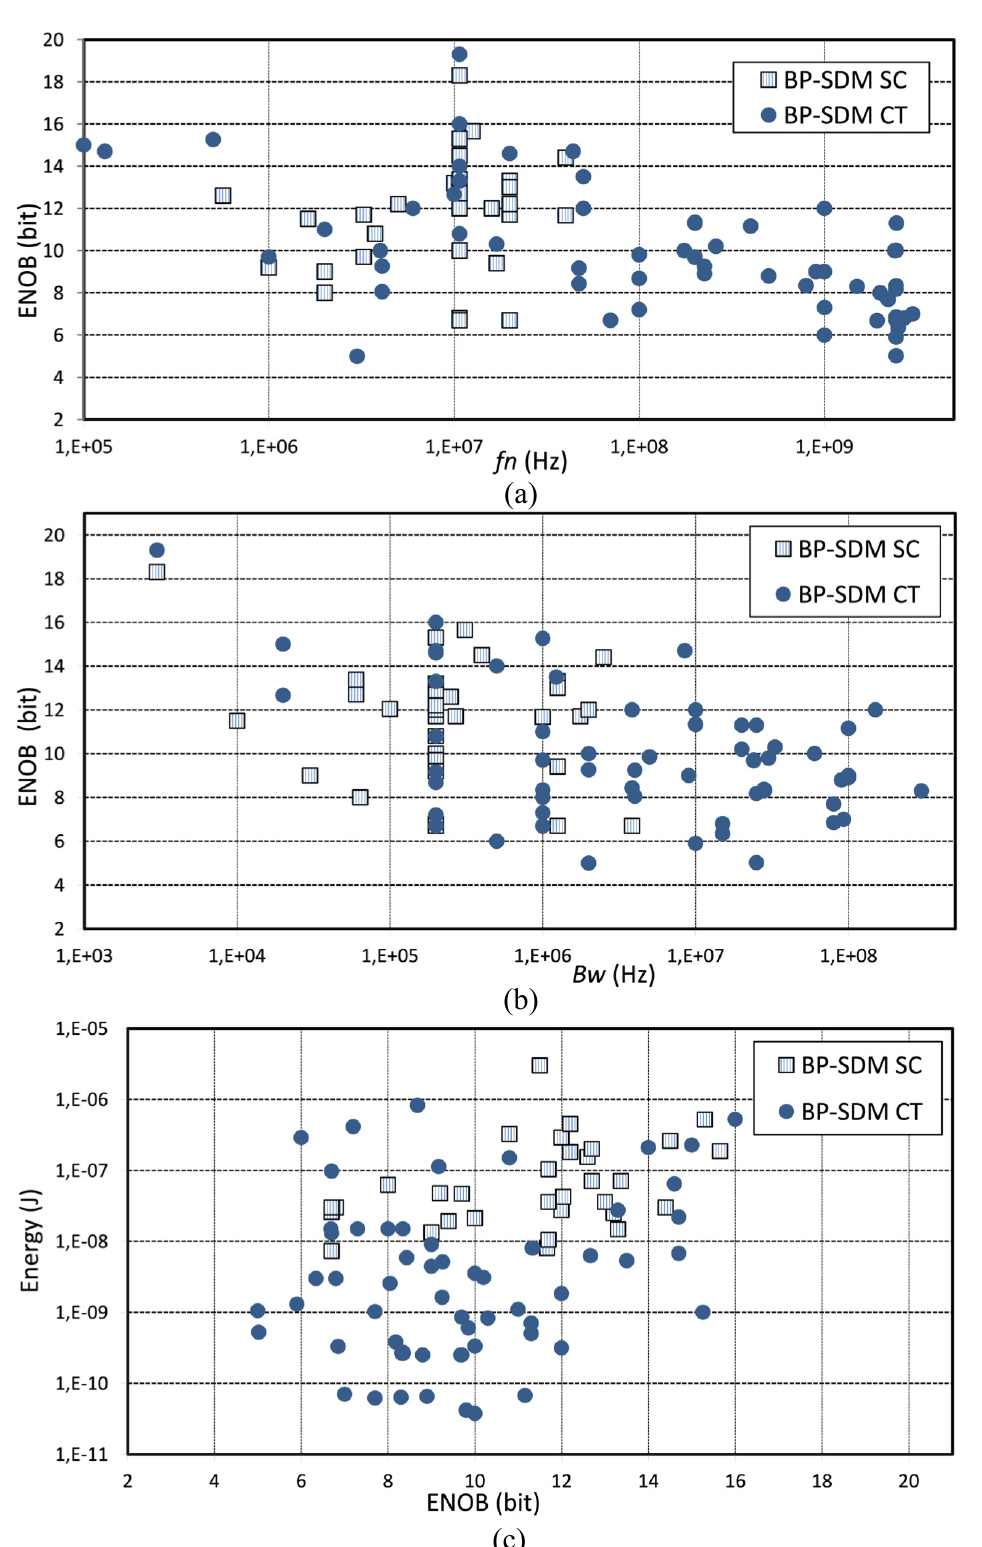
Figure 15. SC vs. CT BP- Σ∆ Ms: ( a ) ENOB vs. f n , ( b ) ENOB vs. B w . ( c ) Energy